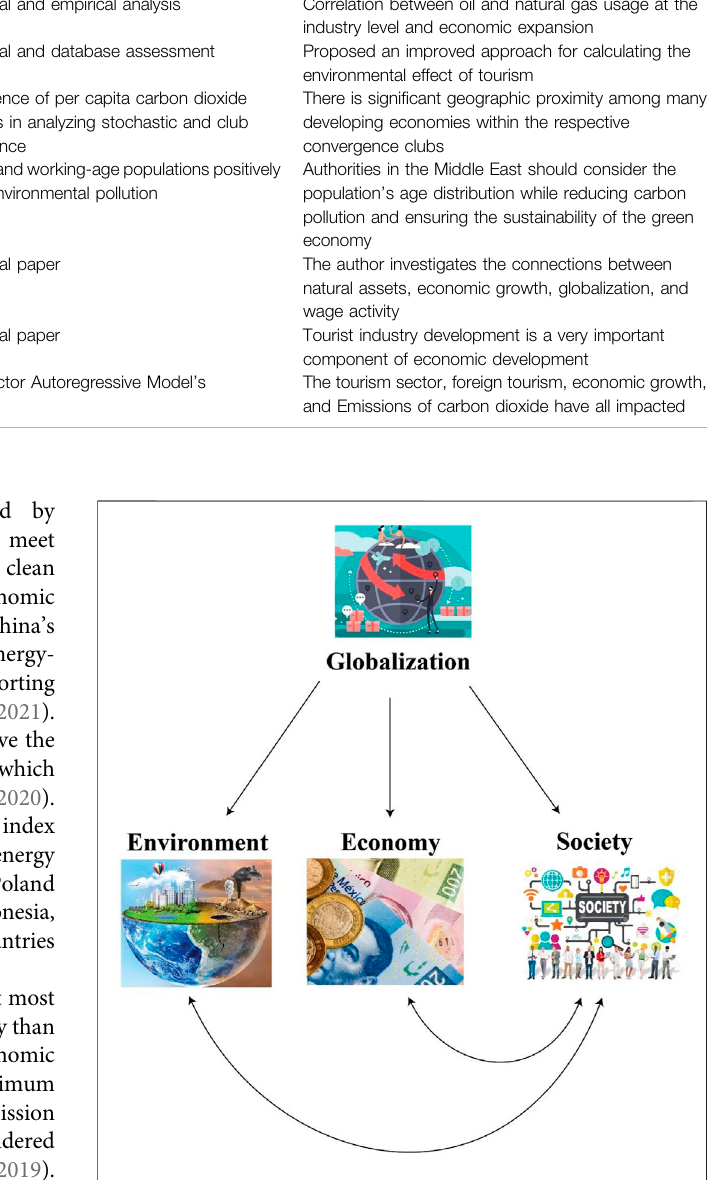
FIGURE 1 | The impact of globalization on the environment, economy, and